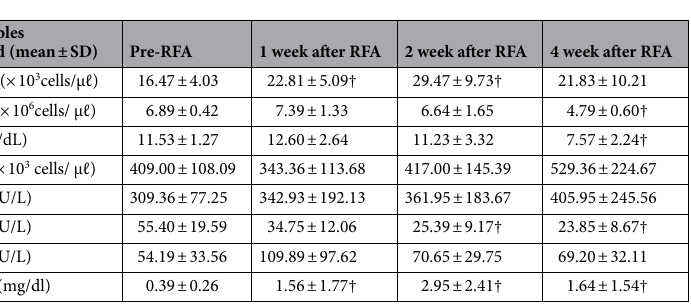
Table 2. Laboratory findings during the third in-vivo animal study step. RFA, radiofrequency ablation; SD, standard deviation; WBC, white blood cells; RBC, red blood cells; Hb, hemoglobin; PLT, platelet; ALP, alkaline phosphate; ALT, alanine transaminase; AST, aspartate transaminase; T.Bil, total bilirubin. † , P < 0.005 compared to